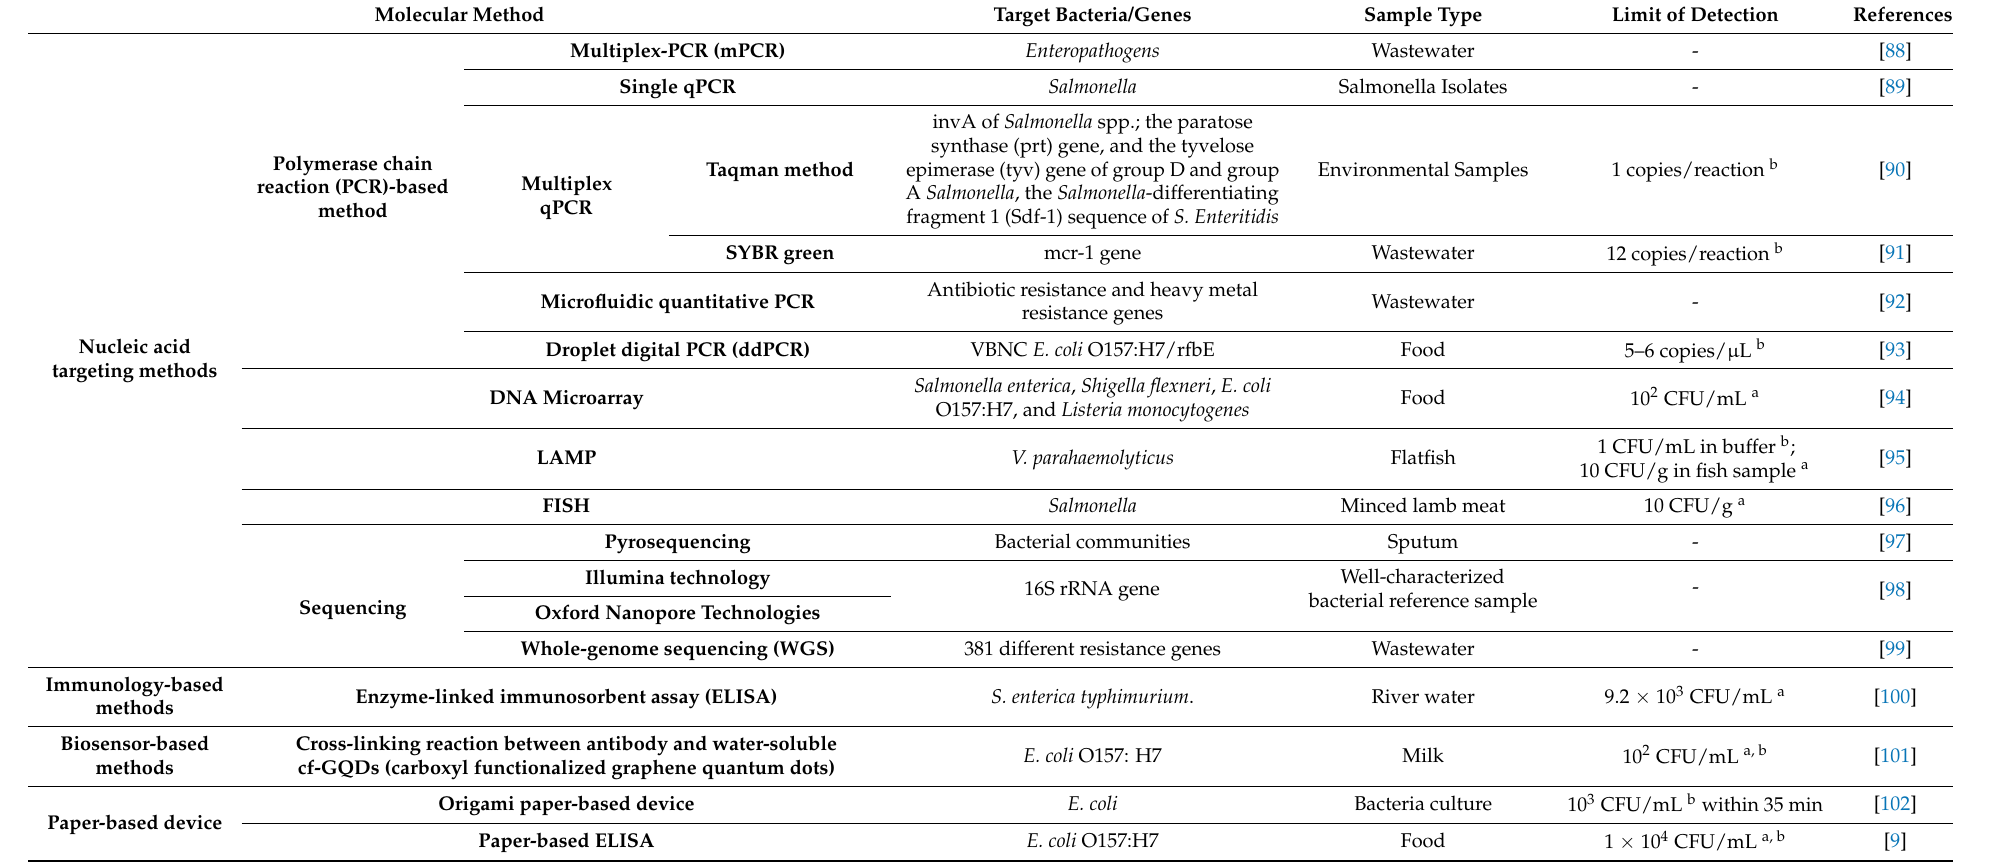
Table 2. Molecular detection methods and example of applications in the analysis of pathogenic